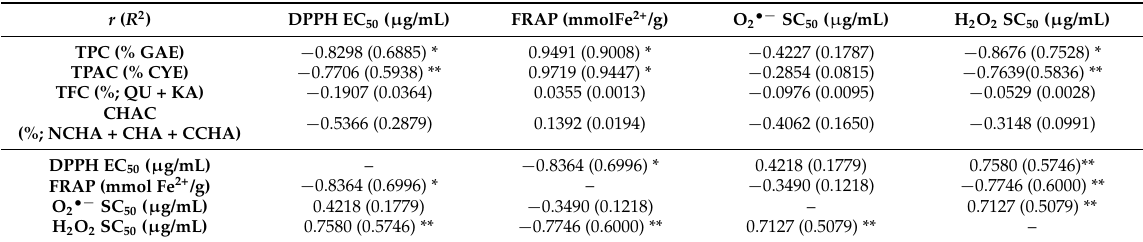
Table 4. Correlation ( r ) and determination ( R 2 ) coefficients for linear relationships between antioxidant capacities and phenolic contents of the Cotoneaster leaf extracts a,b